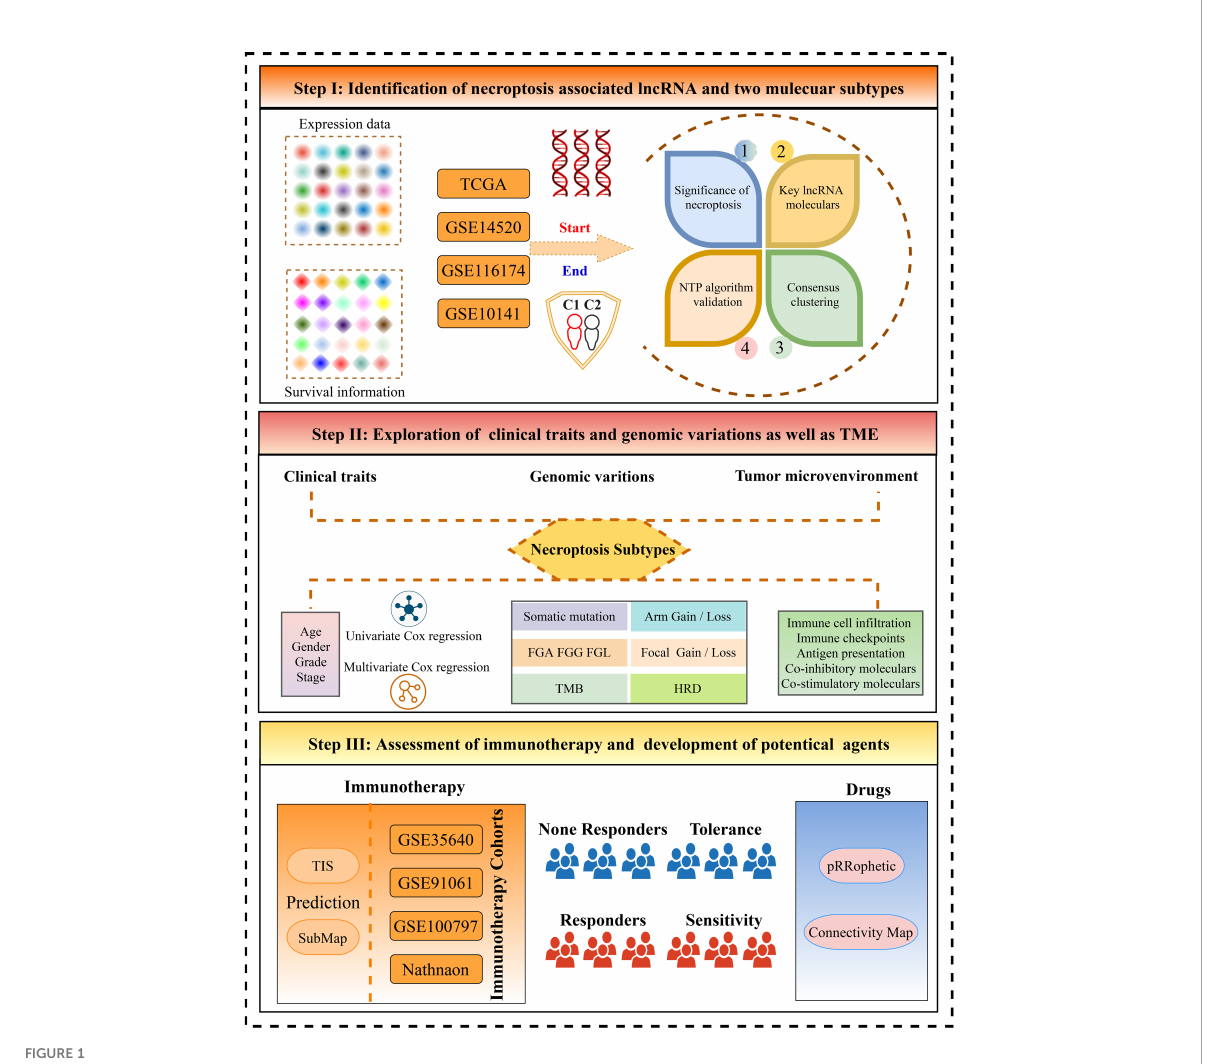
FIGURE 1 The fl ow diagram of this